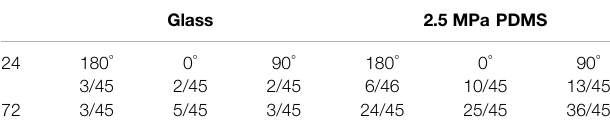
TABLE 1 | Fractioned number of rMSCs with branched perinuclear actin fi bers.